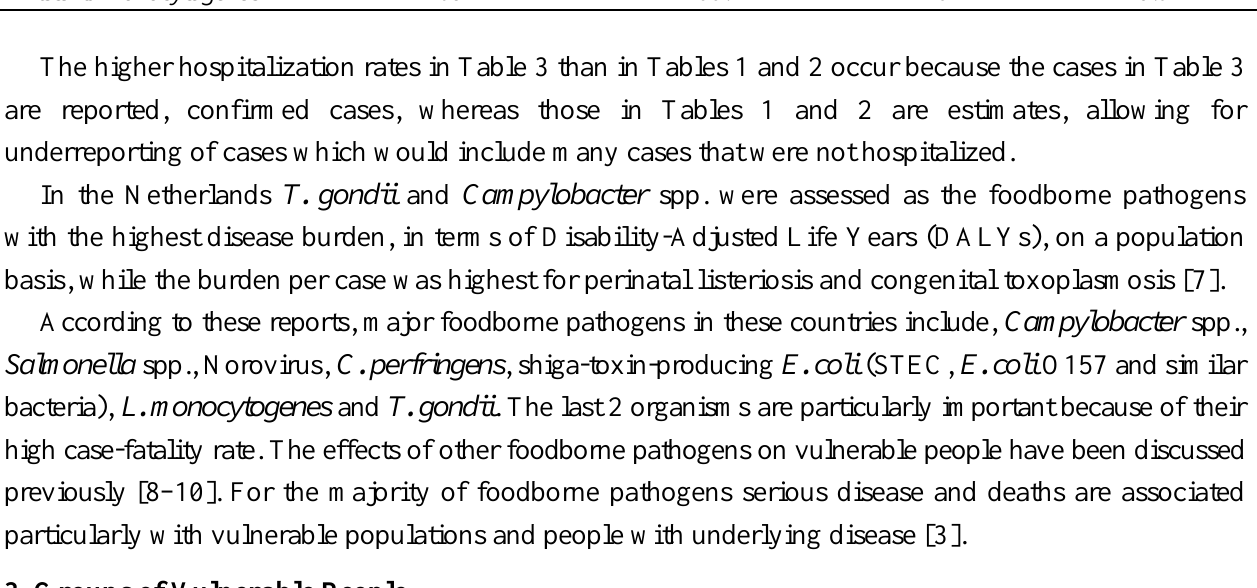
Table 3. Reported cases, hospitalization, deaths and case-fatality rates due to main zoonoses in confirmed human cases in the EU, 2013. Data from [5]. Number of Confirmed Hospitalization Rate Reported Case-Fatality Pathogen Human Cases (%) Deaths Rate (%) Campylobacter spp. 214,779 43.6 56 0.05 Salmonella non-typhoidal 82,694 36.0 Yersinia